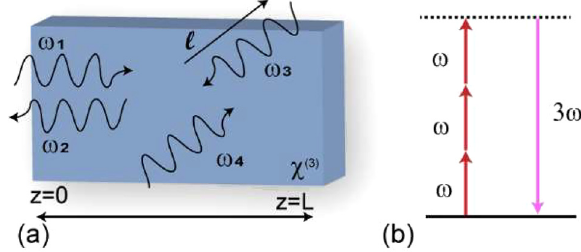
Figure 2: (a) Four waves with frequencies ω 1 , ω 2 , ω 3 , and ω 3 mix in a nonlinear optical crystal exhibiting third-order ( χ (3) ) effects, with two waves propagating in the z -direction and one propagating along vector ℓ . (b) For third-harmonic generation (THG), three photons at the pump frequency are destroyed while interacting with the mate- rial to produce a single photon at triple the pump frequency (1/3 the wavelength). In THG, the incident (pump) photons and third- harmonic photons can propagate in the same